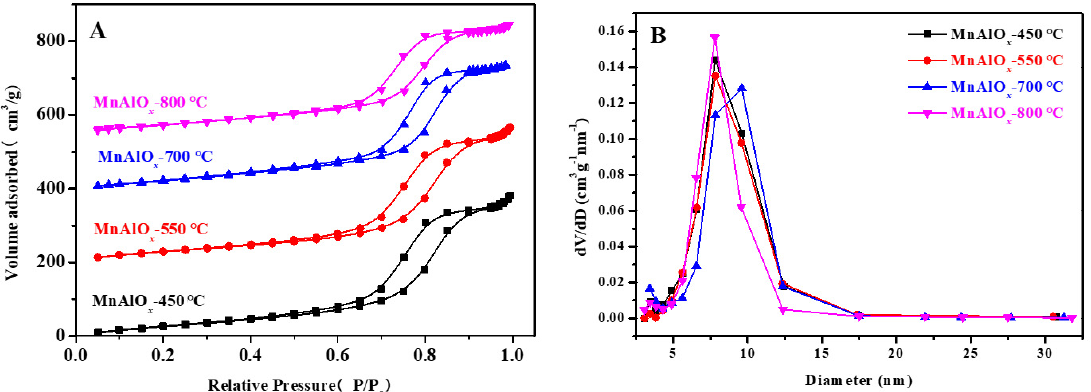
Figure 2. ( A ) N 2 adsorption/desorption isotherm and ( B ) the corresponding pore size distribution for mesoporous MnAlO x catalysts with different calcined temperature.